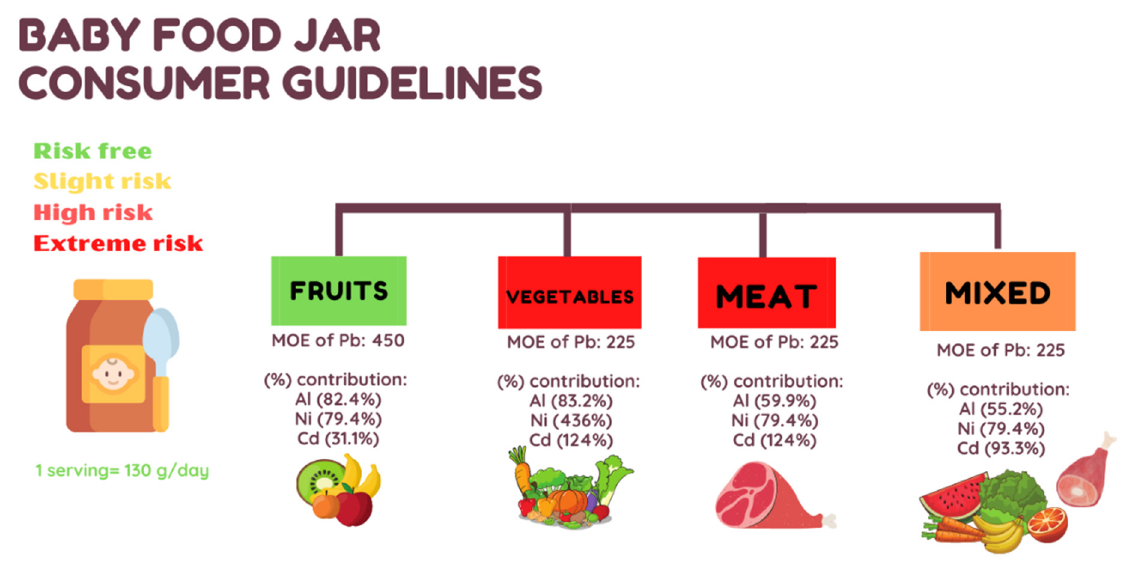
Figure 2. Baby food jar consumer guidelines.